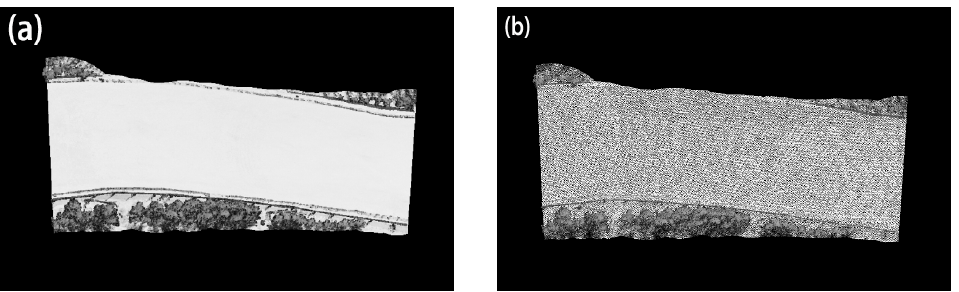
Figure 8. The downsampling results of the second laser point cloud datasets in region A : ( a ) raw data points; ( b ) downsampled points.